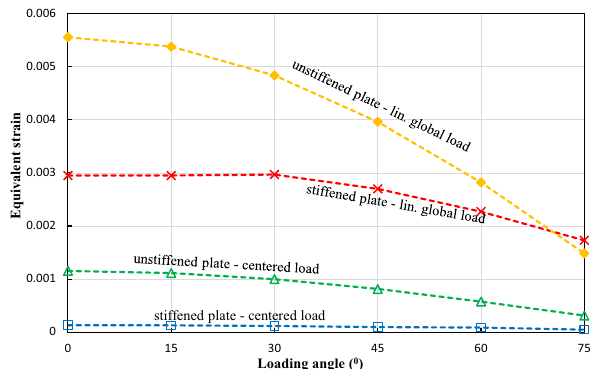
Figure 11: The equivalent strain of sti ff ened and unsti ff ened medium - carbon steel materials.